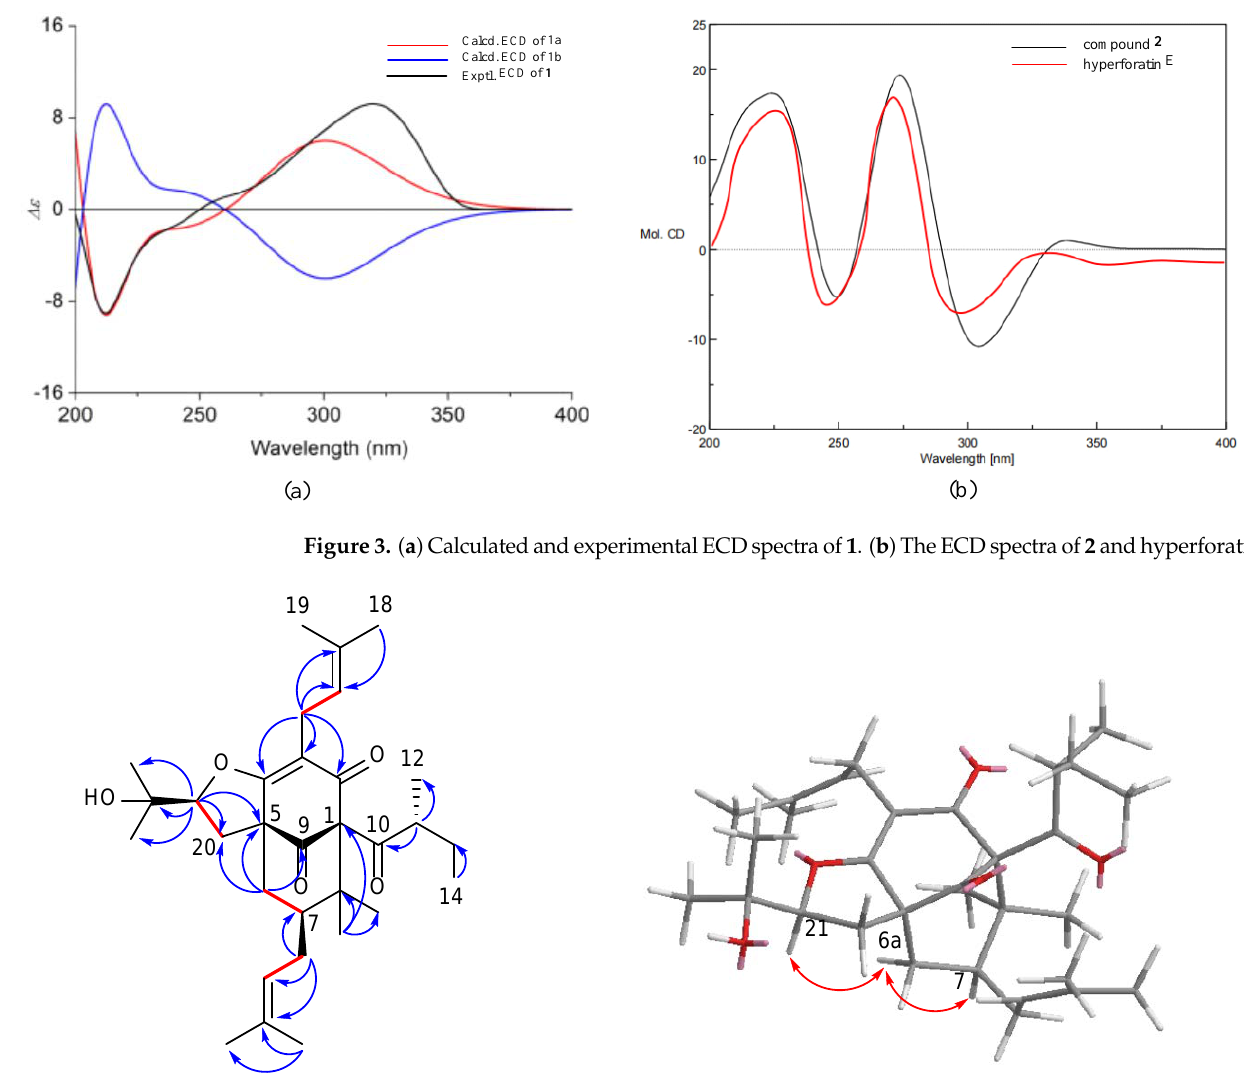
Figure 4. Key 2D NMR correlations of hyperacmosin S ( 2 ).